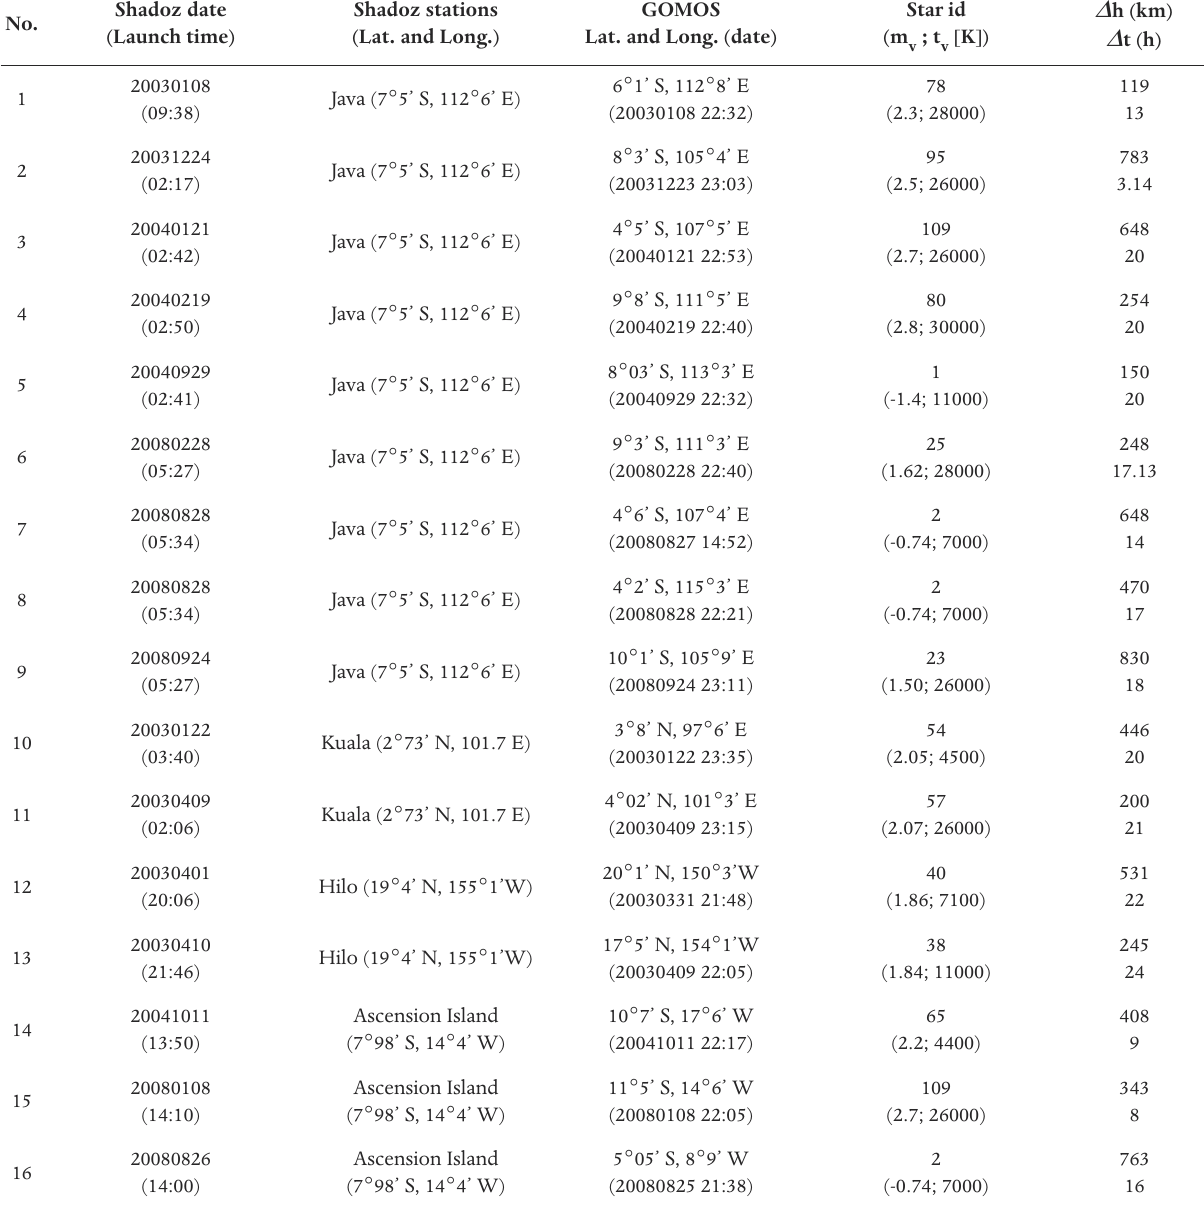
Table 1. Overview of the time and geolocation of SHADOZ measurements and GOMOS available for this study. The table reports also the visual magnitude and effective temperature of stars of which GOMOS products are